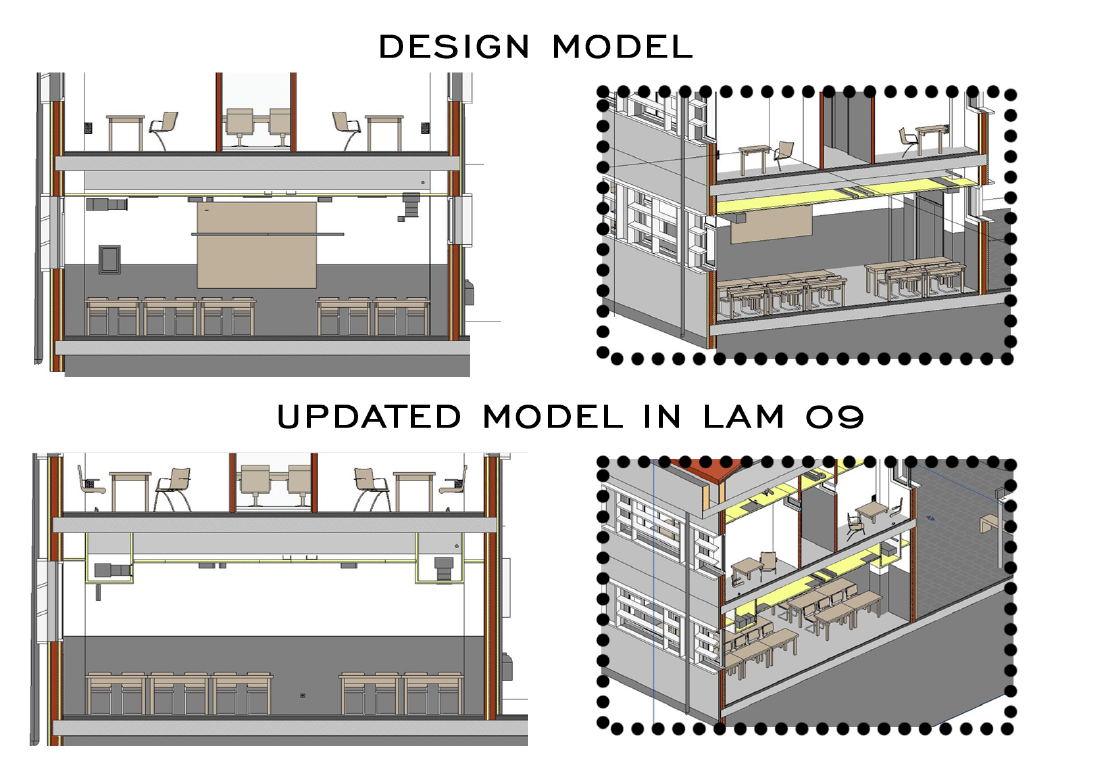
Figure 7. ID_03: Evolution of the design model to a consensual solution by the intervening